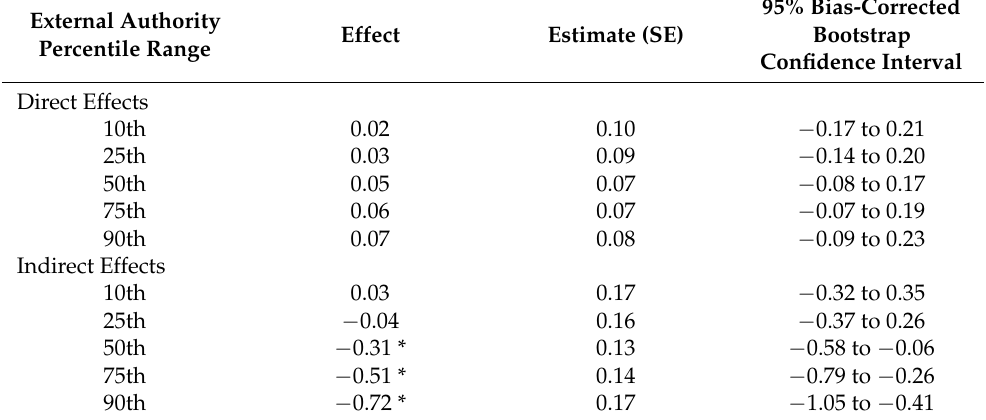
Table 3. Conditional Direct and Indirect Effects in Model with External Authority.